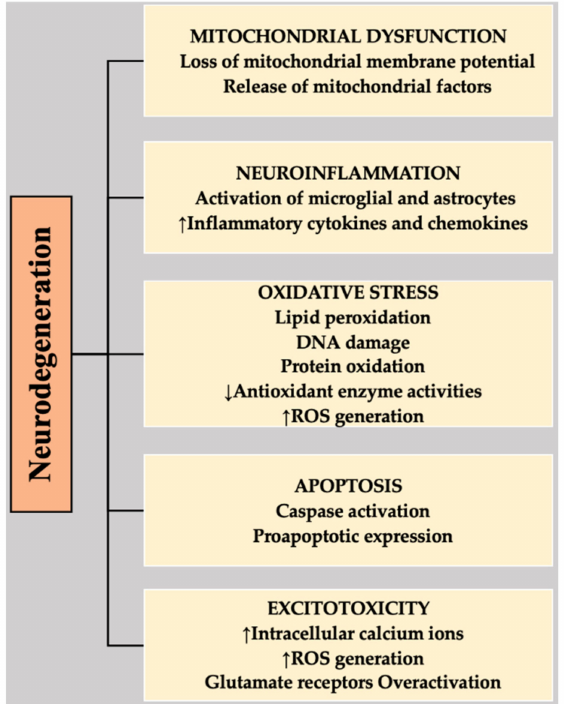
Figure 1. Highlighting the associations of different mechanisms with the neurodegeneration that is involved in NDs. DNA, deoxyribonucleic acid; ROS, reactive oxygen